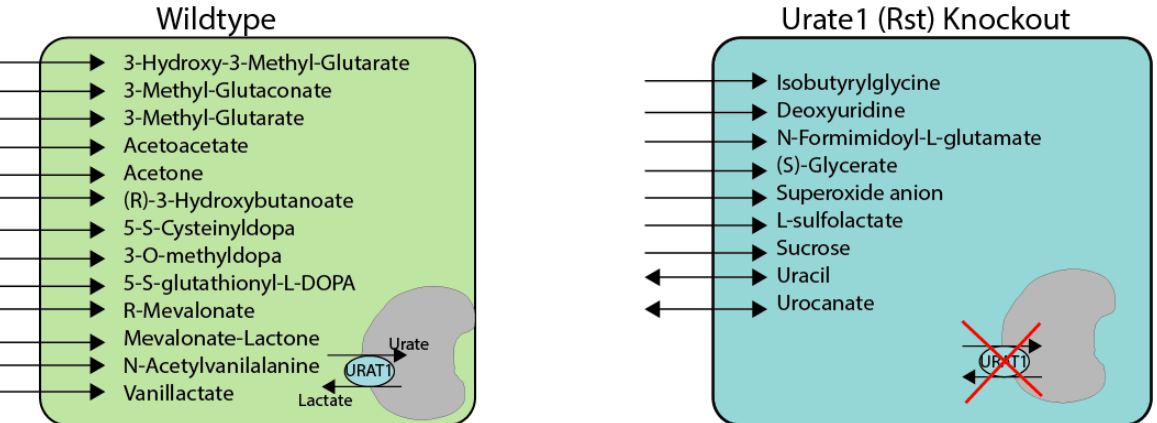
Figure 8. Summary comparison of the unique exchange metabolites for the WT (green, left ) and Urat1KO (blue, right ) models. Loss of URAT1 functionality appears to be accompanied by increased uptake of multiple metabolites that are directly or indirectly linked to redox cofactor balances. Although URAT1 in the kidney proximal tubule is apical, the transport mechanisms correspond to the predicted uptake of metabolites may be apical and/or basolateral and may occur in different